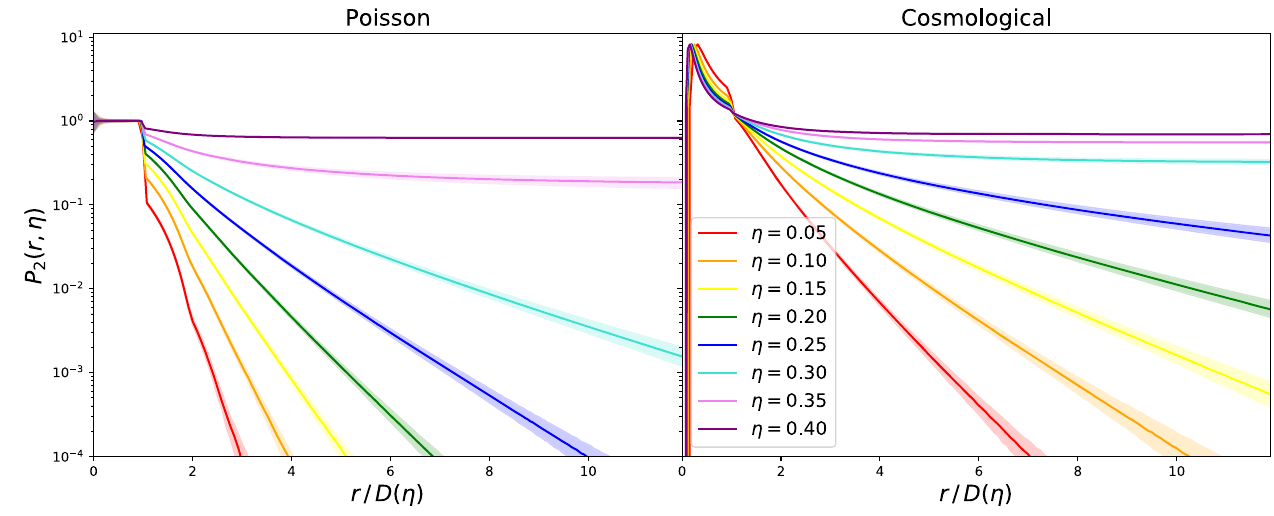
FIG. 6. Pair-connectedness function P 2 ð r; η Þ for the Poisson (left) and cosmological (right) simulations. Results are shown for a variety of reduced densities η , corresponding to clustering distances D ð η Þ in the range ½ 10 ; 20 (cid:2) h − 1 Mpc, and shaded regions show the 1 σ deviations expected from statistical fluctuations. The QUIJOTE simulations show significantly enhanced correlations on large scales, due to the underlying correlations of matter imprinted in the early Universe. This additionally suggests that the galaxy sample will percolate at lower η : this will be explored in Sec.